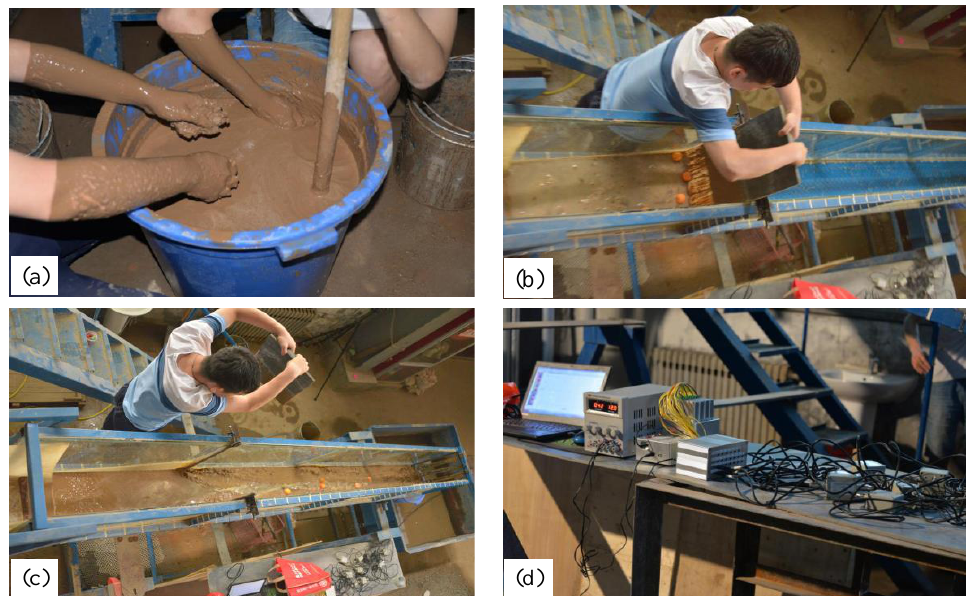
Figure 6. The process of our model experiments: ( a ) make a debris flow slurry; ( b ) raise baffle and release debris flow slurry; ( c ) the movement characteristics of debris flow were recorded by cameras; ( d ) the movement of debris flow were recorded by sensors.